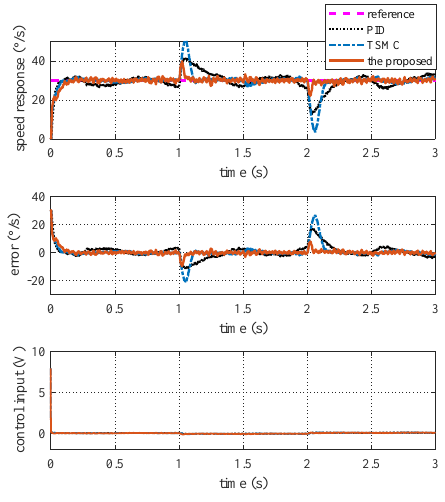
Figure 15. Experimental response curves under Case II.